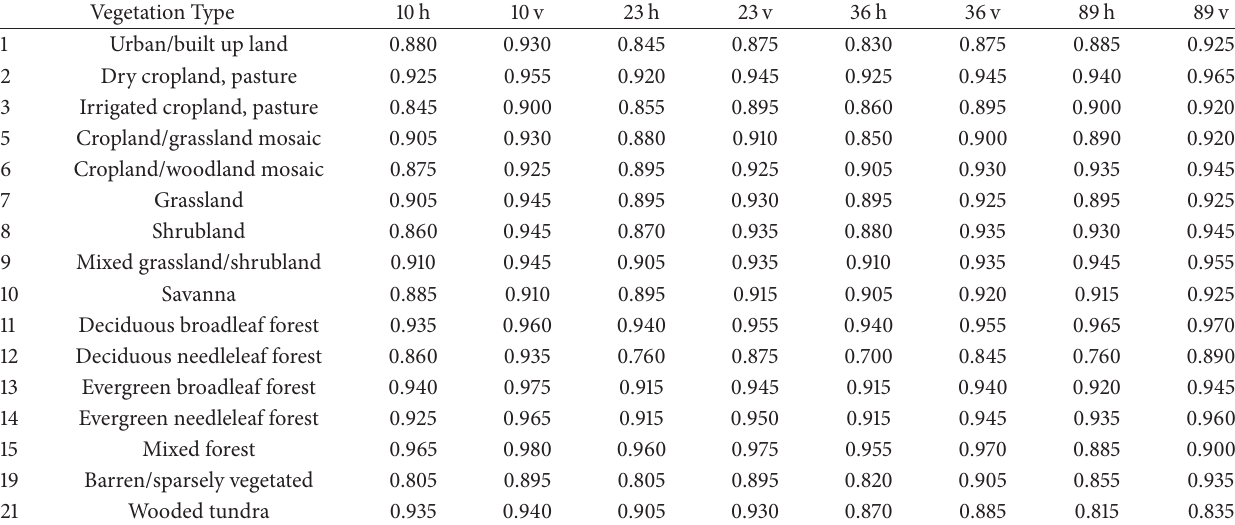
Table 2: Standard emissivity values for the vegetation types found in the innermost domain of the